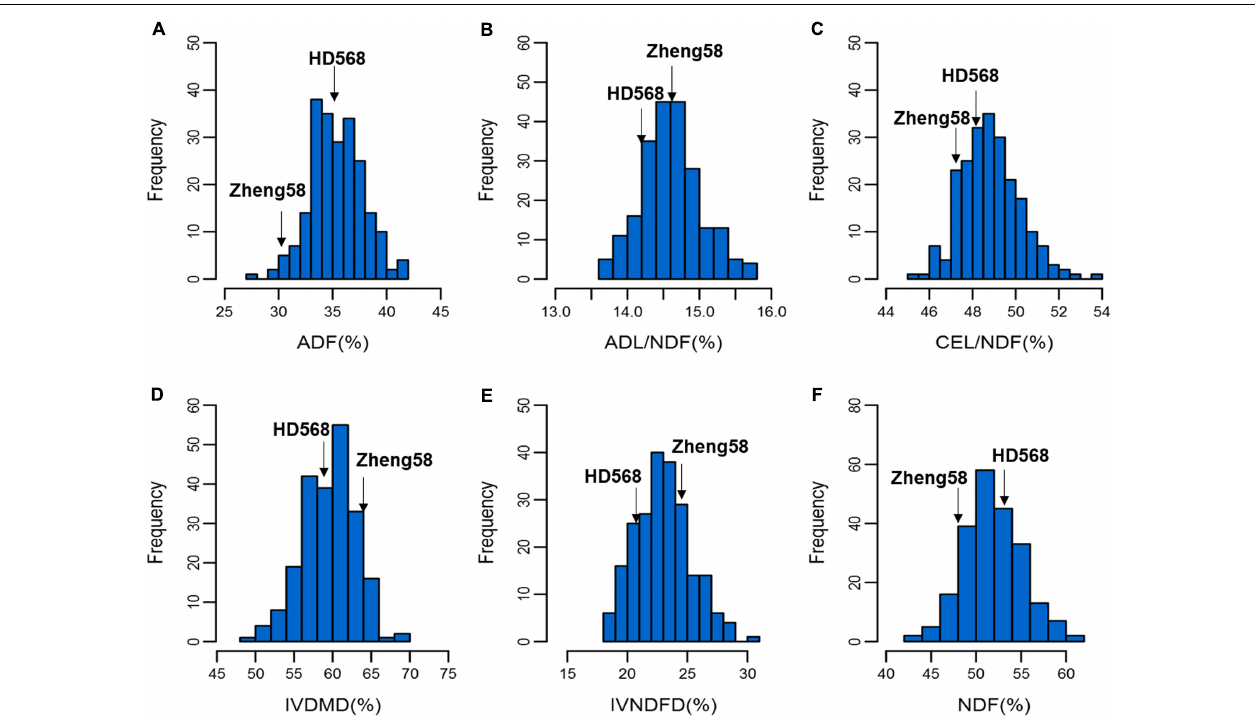
FIGURE 1 | Distribution of cell wall components and digestibility in the RIL population. The frequency distributions of ADF, ADL/NDF, CEL/NDF, IVDMD, IVNDFD, and NDF in the RIL population are shown in (A–F) , respectively.